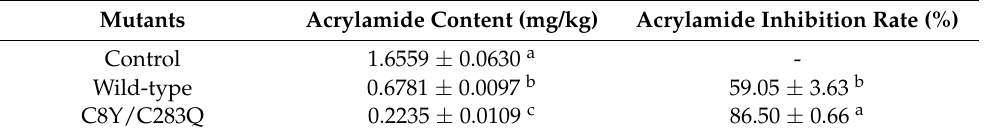
Figure 7. Acrylamide determination by LC–MS after treatment with AsA wild-type and mutant C8Y/C283Q. Table 6. Acrylamide contents in potato slice samples after treatment with AsA wild-type and mutant C8Y/C283Q.